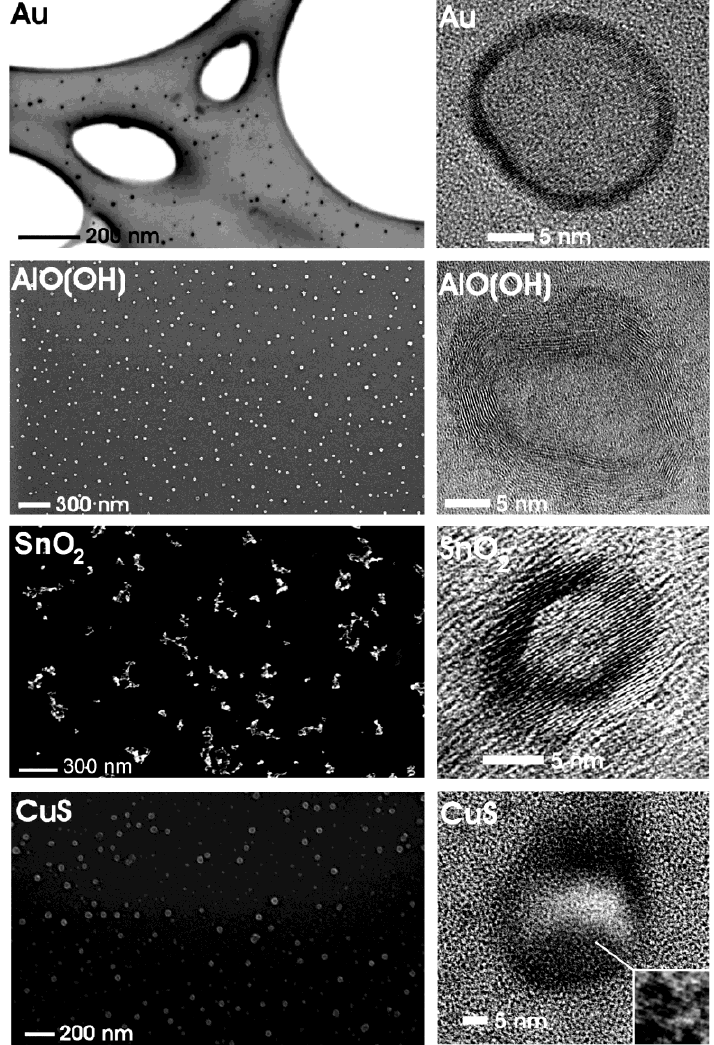
Figure 4. Overview of nanoscale hollow spheres with various compositions gained via the microemulsion approach (modified reproduction from